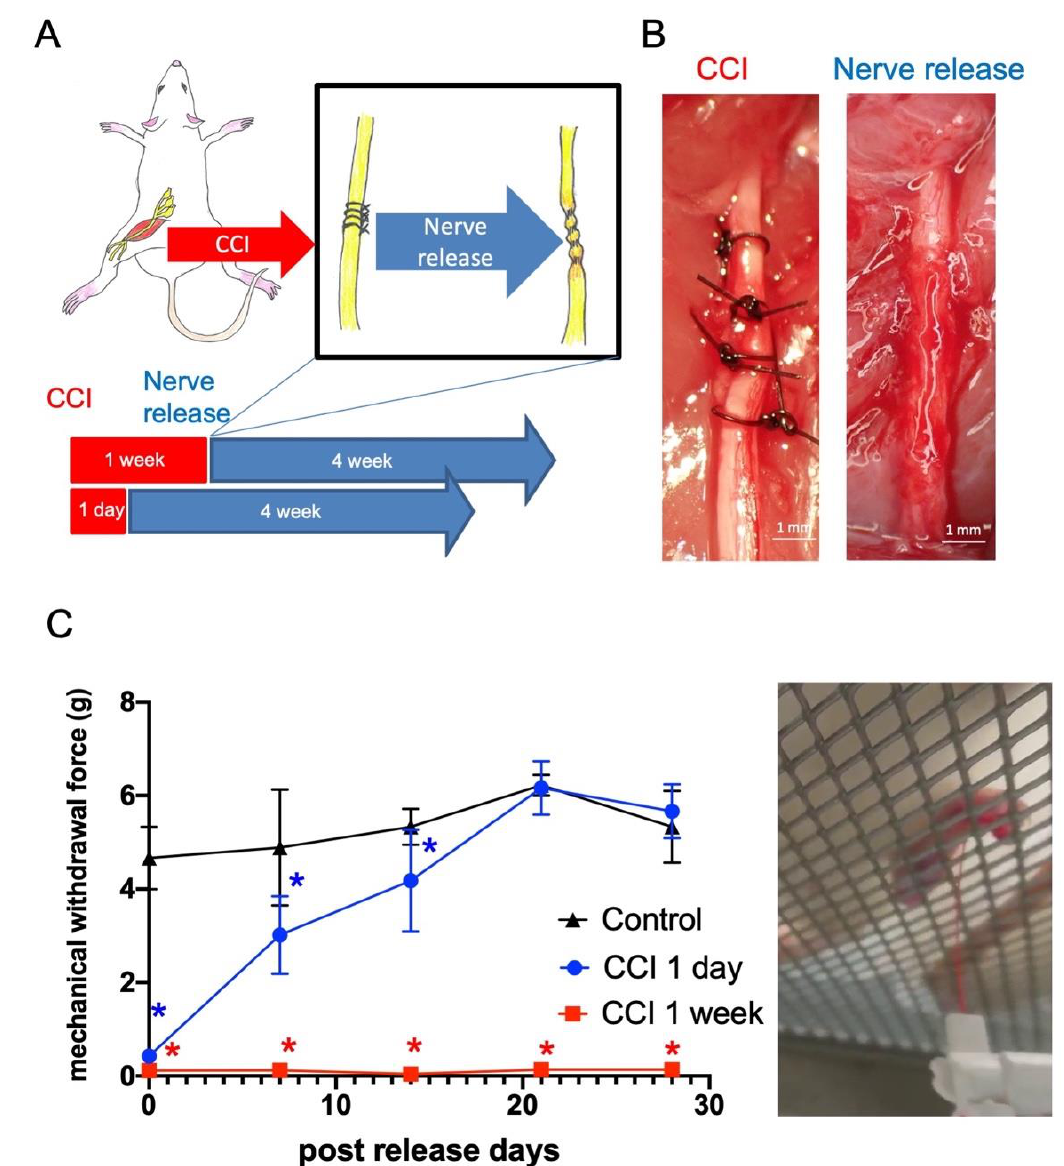
Figure 1. Chronic constriction injury model and sensory outcome. ( A ) Animal model of chronic constriction injury over ipsilateral sciatic nerve. Two time periods of constriction, followed by nerve release at 1 day and 1 week. ( B ) Controllable mechanical constriction forces were applied with four sutures. Nerve release was performed by neurolysis and removal of all sutures at 1 day or 1 week after constriction. Scale bar: 1 mm. ( C ) Mechanical allodynia was evaluated by Von Frey test over hind paw of rats. The mechanical withdrawal force (g) indicated that the forces that induced paw withdrawal by Von Frey test. (Data was presented with mean ± standard deviation, * indicated statistical significance as compared to control group; p < 0.05).